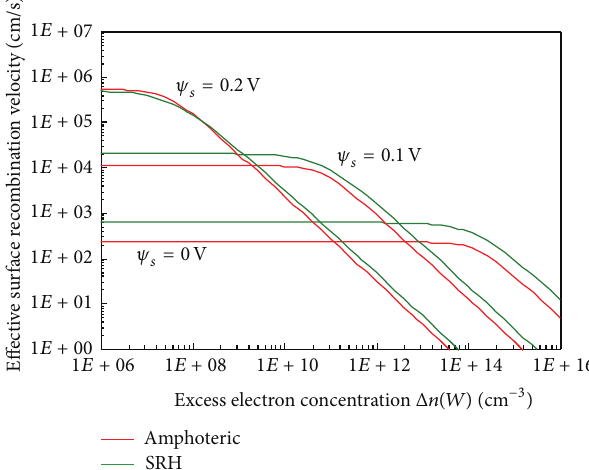
Figure 3: Effective surface recombination velocity as a function of excess electron concentration for both SRH and amphoteric center = 0 : (a) at flat band (𝜓 = 0) , (b) 𝜓 = 0 .1 V, recombination for 𝐸 𝑠 𝑠 corr (c) 𝜓 𝑠 = 0.2 V. The ratio 𝜎 𝑛 /𝜎 𝑝 = 𝜎 0 𝑛 /𝜎 0 𝑝 = 100